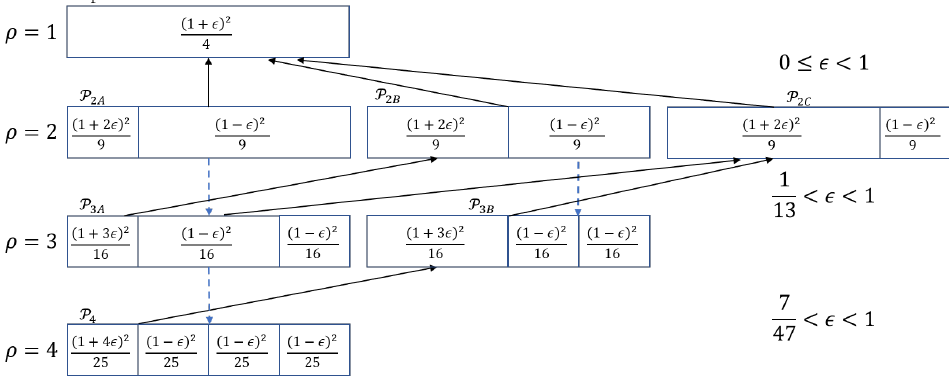
Figure 2. Splits and mergers among four